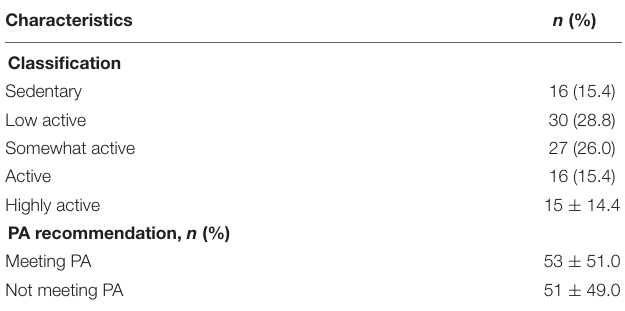
TABLE 5 | Classification of older individuals according to PA Guidelines ( n =